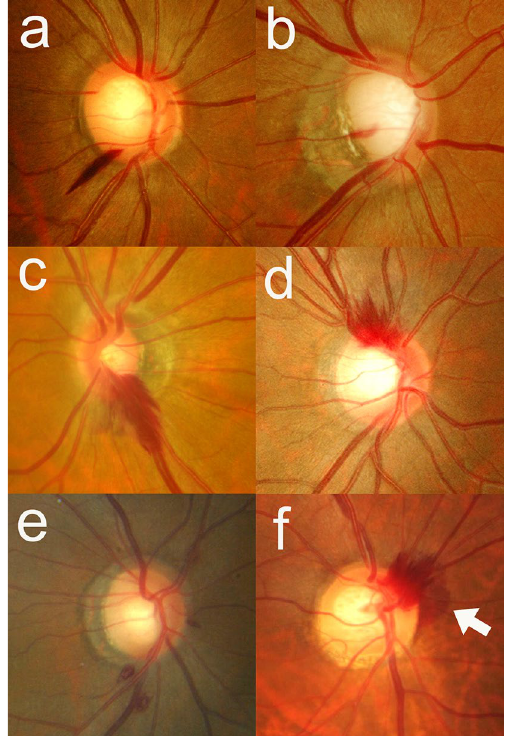
Figure 1. Representative fundus photographs of posterior vitreous detachment (PVD)-related and glaucomatous disc hemorrhage (DH). Splinter-shape glaucomatous DH with disc rim type ( a ), splinter-shape glaucomatous DH with lamina cribrosa type ( b ), flame-shape PVD-related DH with cup margin type ( c,d ), dot or blot-shape PVD-related DH with a peripapillary type ( e ), and flame-shape PVD-related DH with cup margin type ( f ) in combination with subretinal hemorrhage (white arrow) are presented.